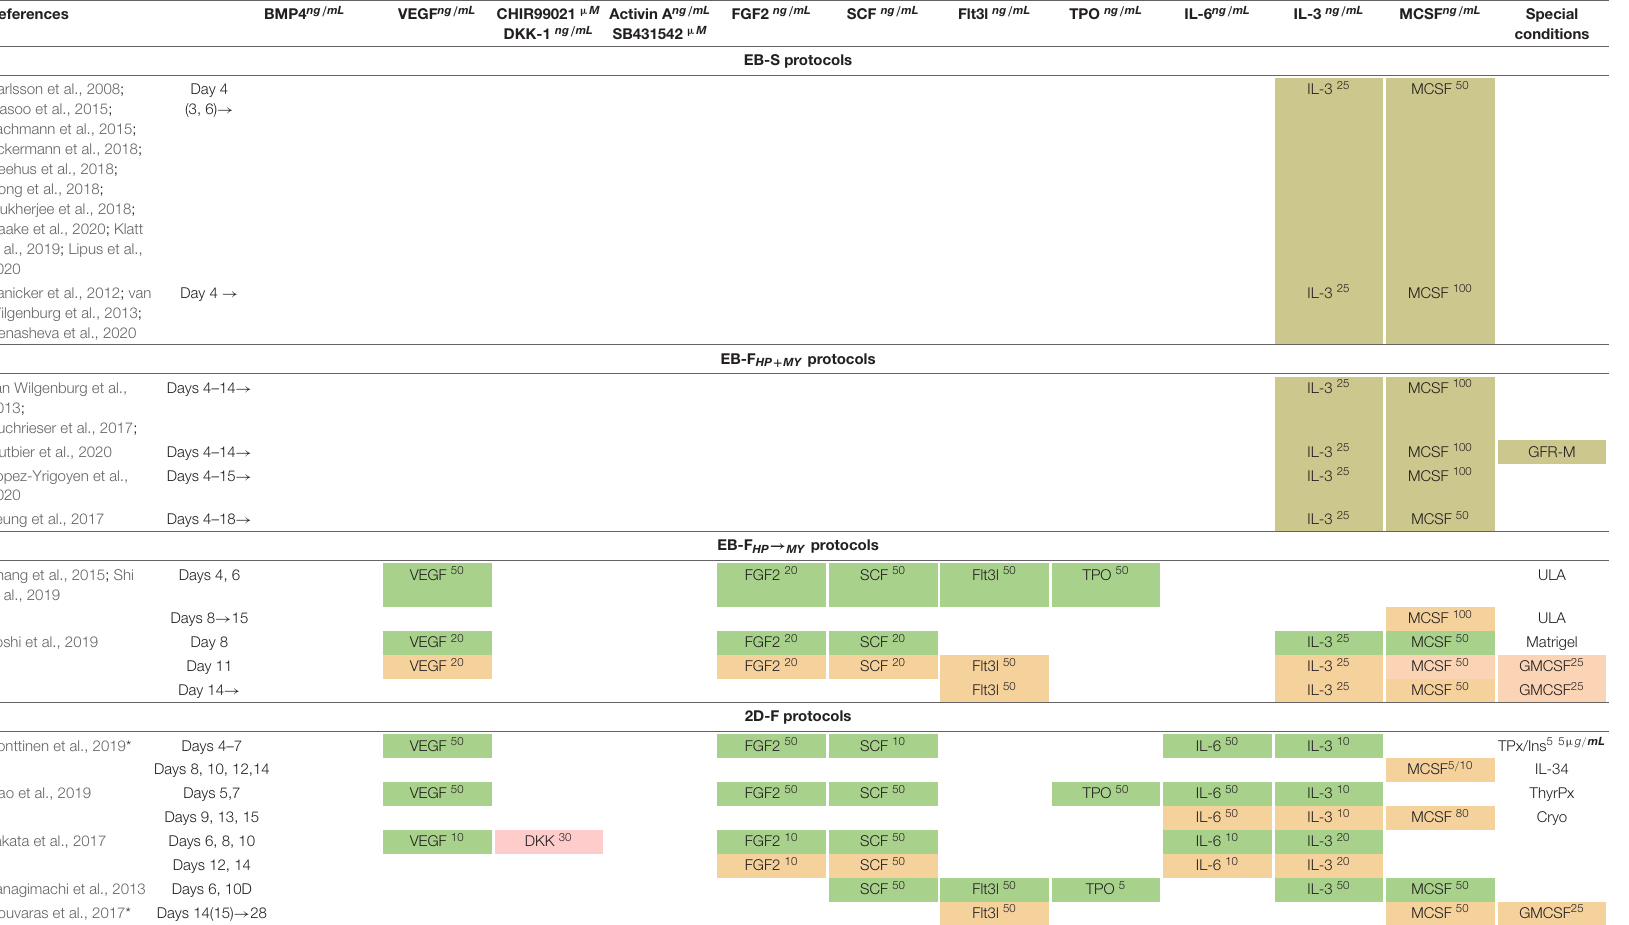
TABLE 6 | Combinations of exogenous factors used to drive iMph differentiation at HP and MY stages.